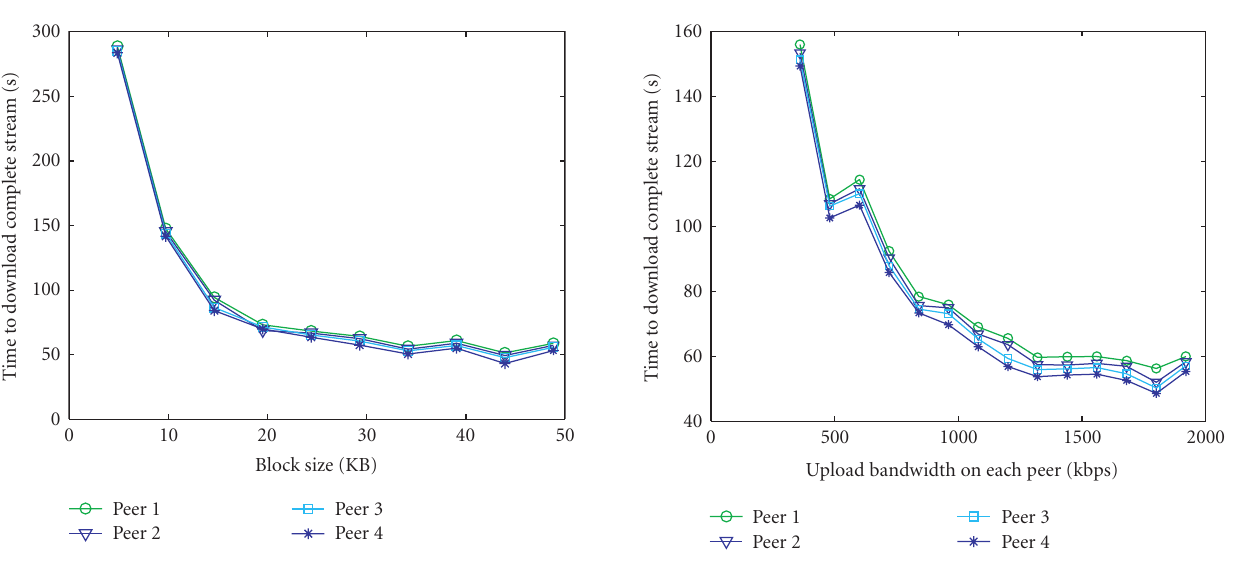
Figure 11: Time to download versus the block size.